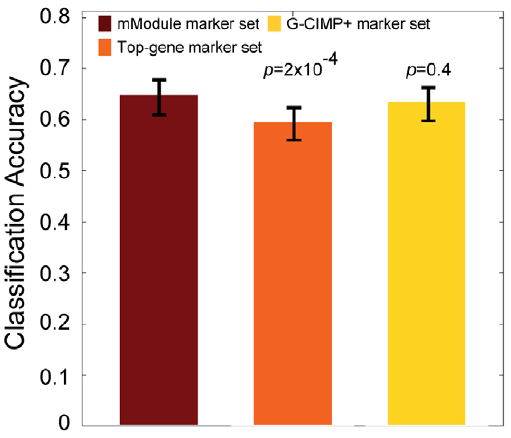
Figure 2. Performance comparison of DNA methylation-based classifiers for GBM patient prognosis. Promoter DNA methylation data of 42 GBM patients was used to derive the set of mModules. Top- gene set is top 38 (size-matched to the mModule set) most significantly differentially methylated genes between LTS and STS GBM patients. G- CIMP + set, a set of 1228 discriminative genes reported in [6]. Two hundred thirty seven additional GBM patients from TCGA were used for testing classification accuracy. Error bar is the standard deviation based on 100 leave-one-out cross validations. P-values are based on t-tests comparing the average classification accuraciy of the